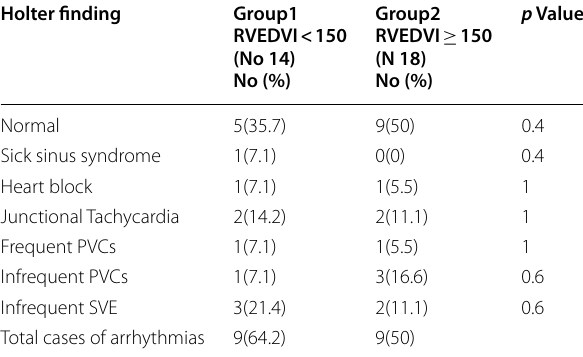
PVCs premature ventricular complexes, SVE supraventricular